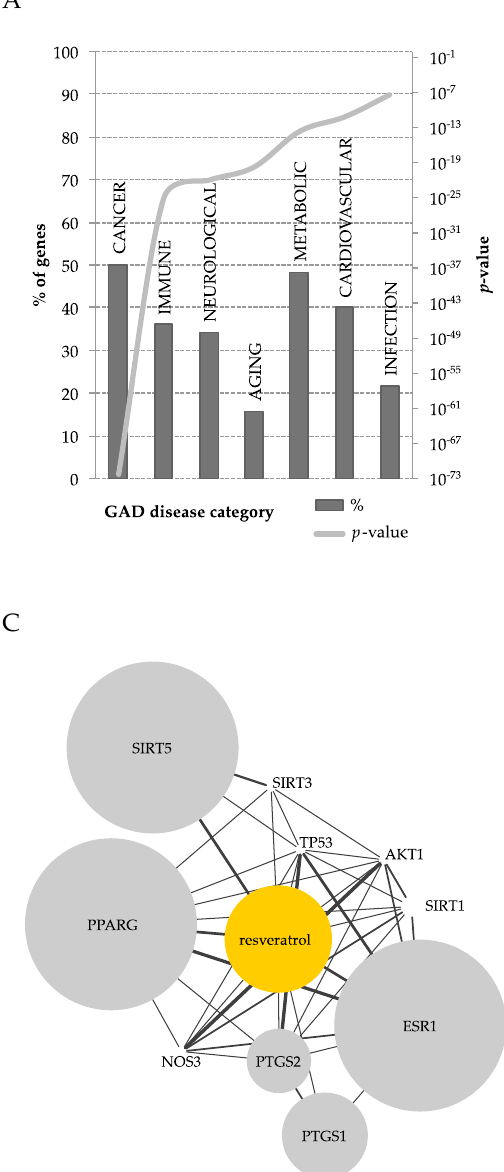
Figure 3. Using Lacroix et al.’s [81] human polyphenol-protein interactome, proteins (743) interacting with resveratrol and dihydroresveratrol were functionally analyzed in DAVID [82]. ( A ) Resveratrol interacting genes annotated according to the genetic association database (GAD) [83] disease categories, according to percentage of genes and p -value. ( B ) Clustering of protein super-families according to the InterPro [84] protein classification, at the highest stringency (in yellow, protein classes represented in ( C ). ( C ), Human resveratrol-protein interactome using experimental evidence obtained from STITCH [89]. The size of the node reflects the strength of the resveratrol-protein interaction. Depicted proteins: peroxisome proliferator-activated receptor gamma (PPARG), NAD-dependent deacetylase sirtuin-1 (SIRT1), 3 (SIRT3) and 5 (SIRT5), nitric oxide synthase 3 (NOS3), prostaglandin-endoperoxide synthase 1 (PTGS1) and 2 (PTGS2), estrogen receptor 1 (ESR1), tumor protein p53 (TP53), and AKT serine/threonine kinase 1 (AKT1).